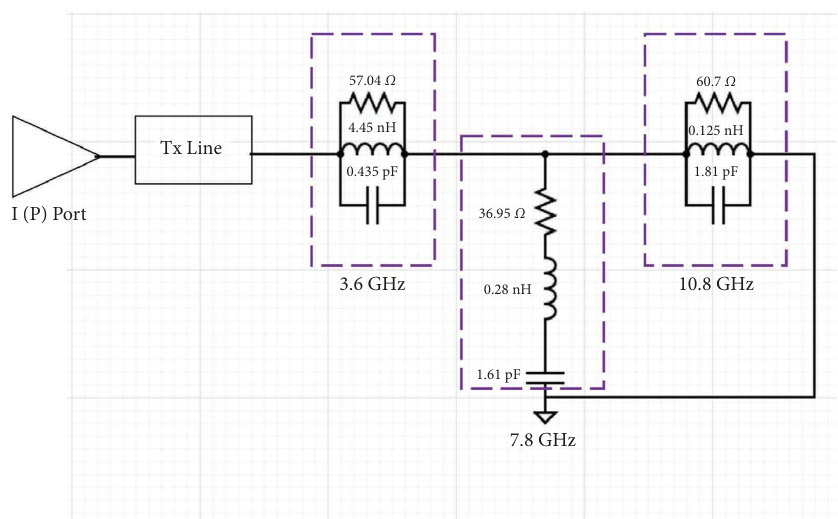
Figure 5: Equivalent circuit plot of the proposed antenna.